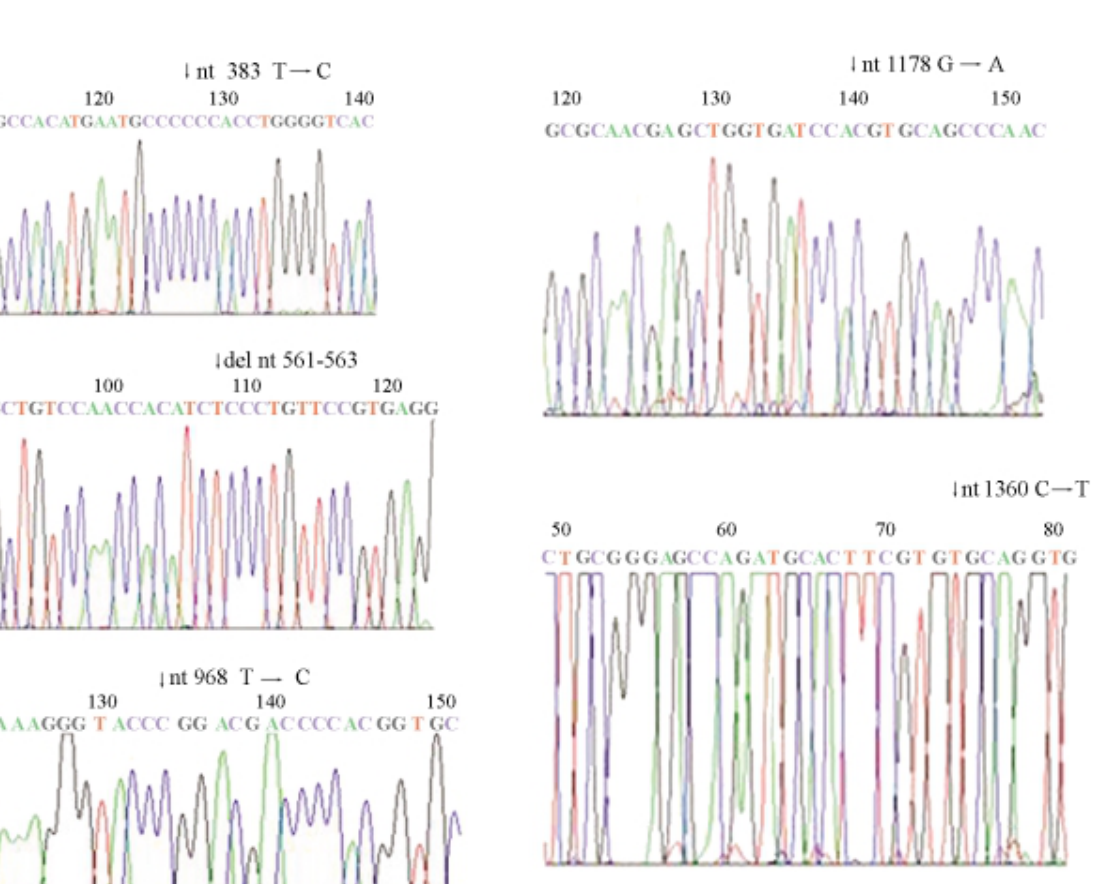
Figure 2 - Sequence analysis of a portion of exons 10, and 11 showing the mutations at nt 1178 G (cid:1) A and nt 1360 C (cid:1)